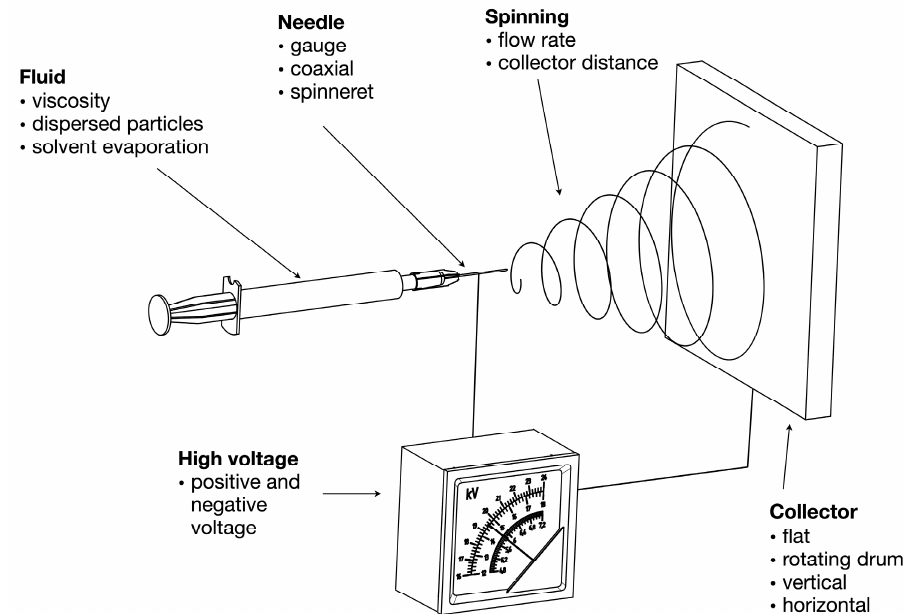
Figure 2. Schematic representation of a classical electrospinning setup for the fabrication of nanofibres as a function fluid properties (viscosity and polymer molecular weight), nature of the solvent, type of needle (coaxial, gauge, spinneret), high voltage applied, flow rate, collector distance and type of collector (flat, vertical, horizontal or rotating drum).